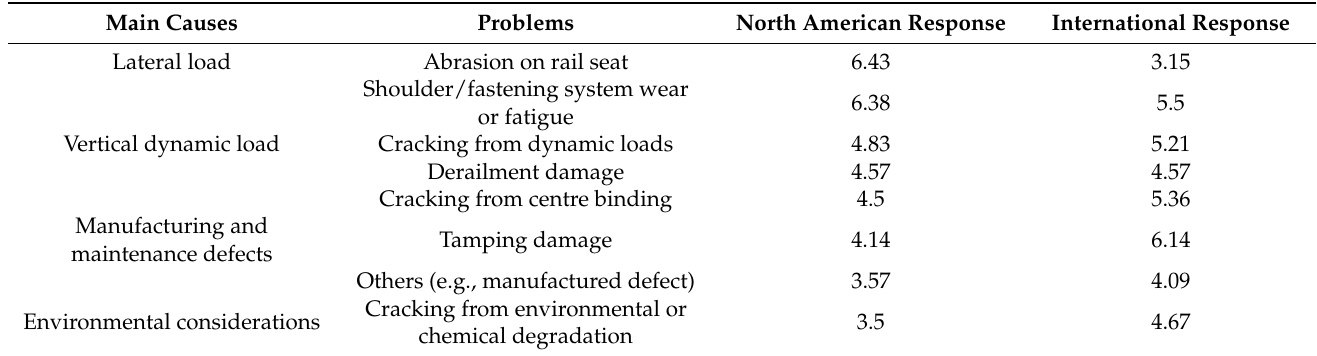
Table 1. Most commonly found problems related to railway concrete sleepers based on international survey outcomes from railway industry networks globally (ranked from 1 to 8, with 8 being the most